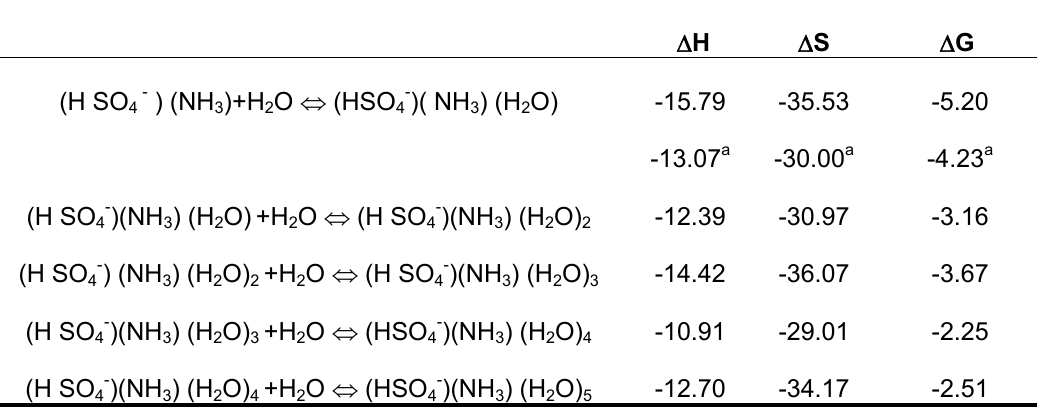
Table 3. Enthalpies (kcal mol -1 ), entropies (cal mol -1 K -1 ), and Gibbs free energy